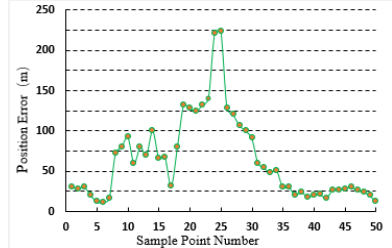
Figure 8. Positioning accuracy of the approximate waterline.